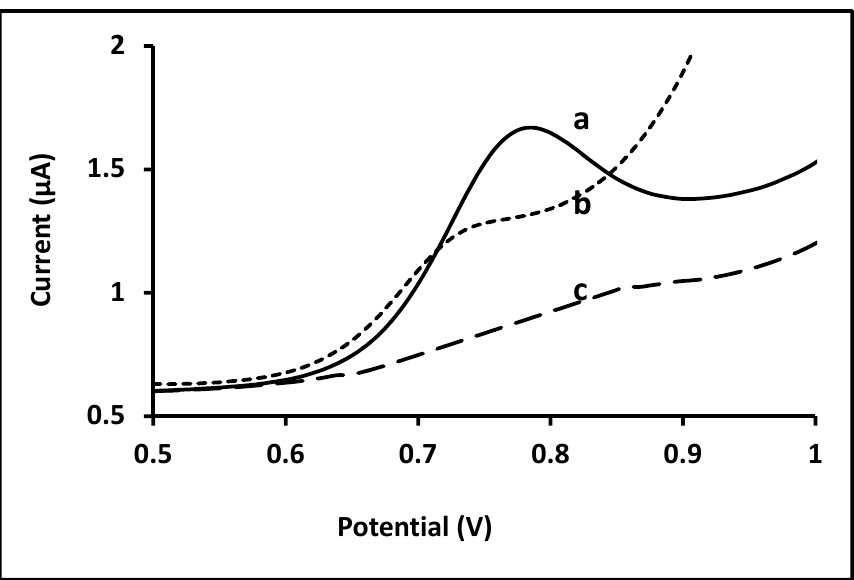
Figure 6. Differential pulse voltammetry of 10 µ M CFN in 0.1 M BR buffer solution ( a ) on CFN-MIP sensor after removal step; ( b ) on bare GC electrode and ( c ) NIP electrode.